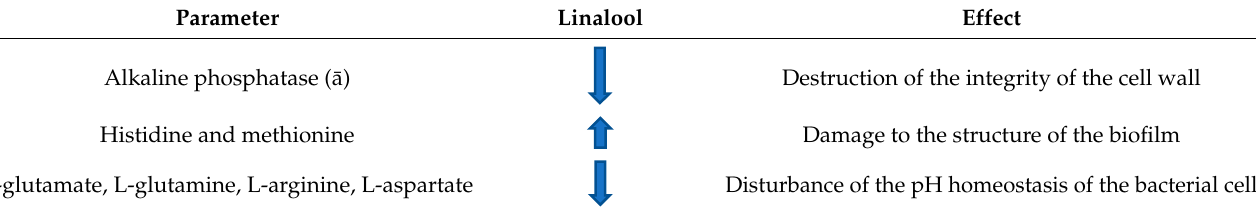
Table 3. Effect of linalool on amino acid metabolism. Parameter